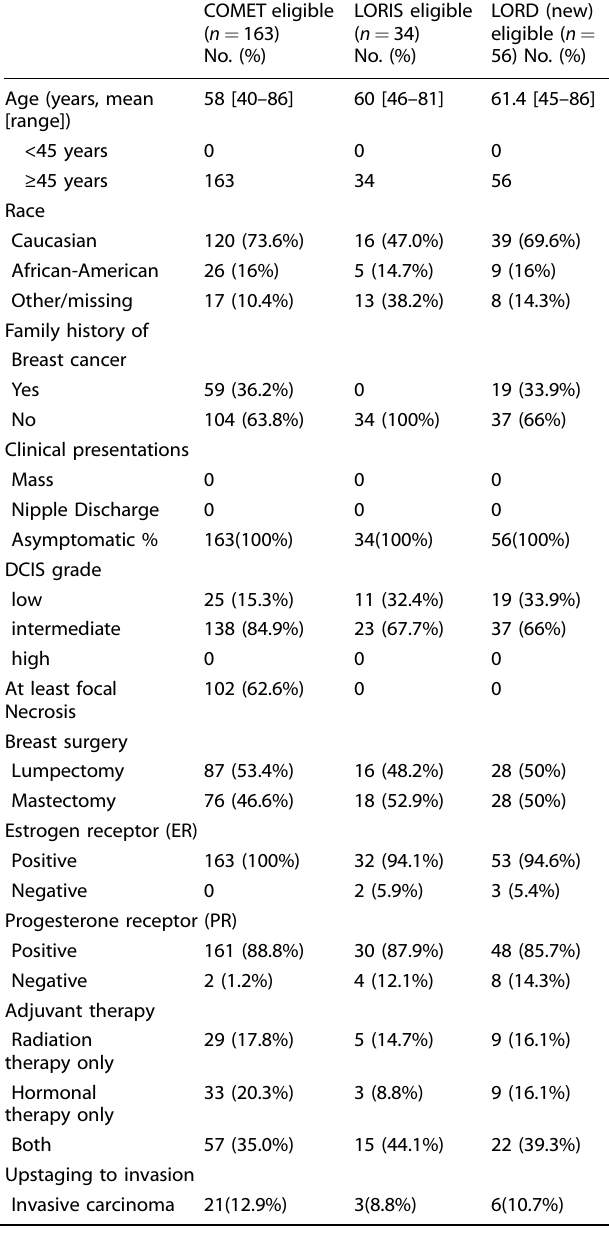
Table 3. Clinicopathological and treatment characteristics of patients in a subset of patients who would have met eligibility conditions for clinical trials using nonsurgical approaches. COMET eligible ( n =